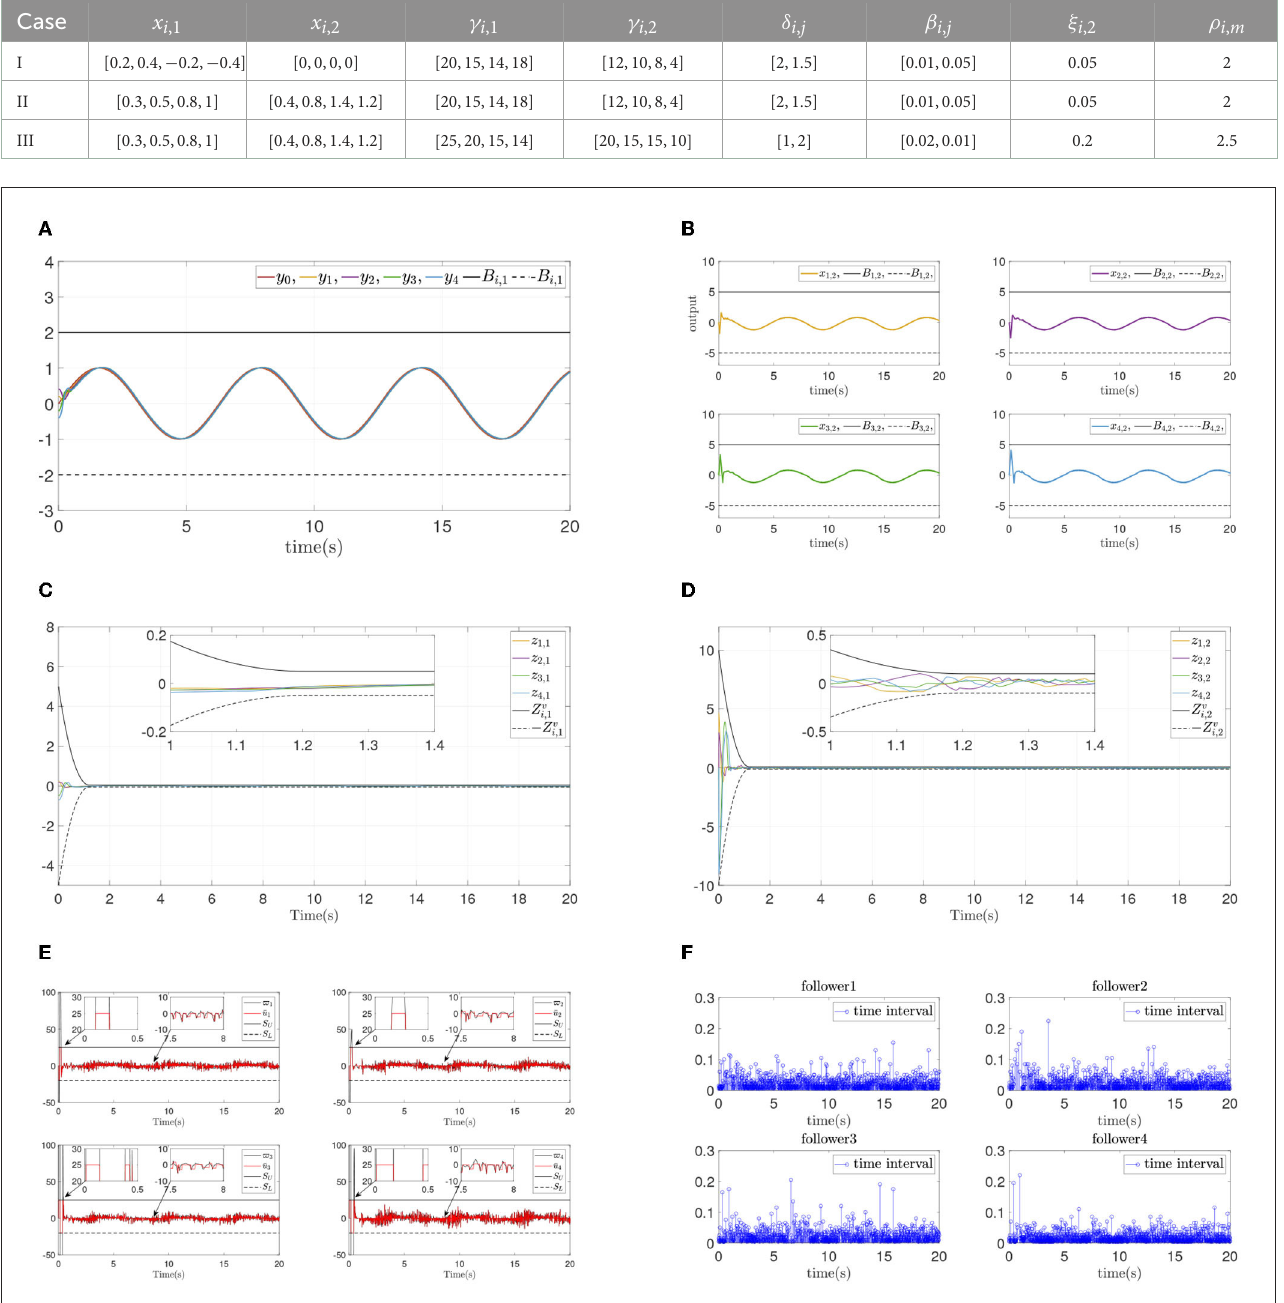
TABLE 1 System’s initial states and controller parameters of Example